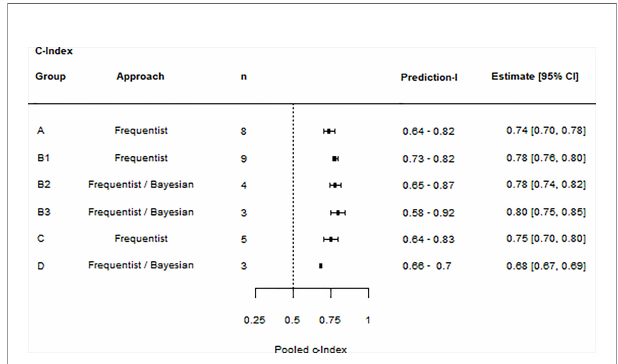
FIGURE 4 | Summary forest plot of c-Index meta-analyses: The forest plot lists the results of individual meta-analyses. For each meta-analysis, the nomogram group, the statistical approach, the number of values included (n), the prediction interval (lower limit – upper limit), and the c-Index summary estimate (estimate and 95% CIs)